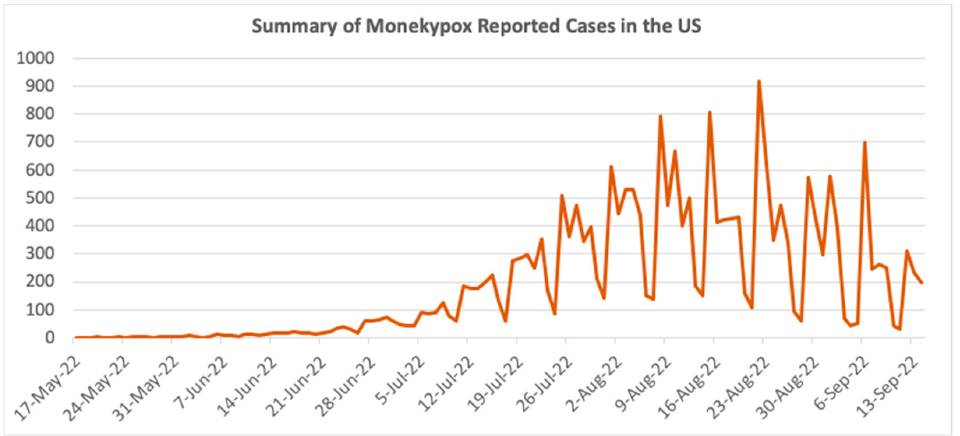
Figure 2. Summary of Monkeypox reported cases from 17 May 2022 to 14 September 2022 in the USA.